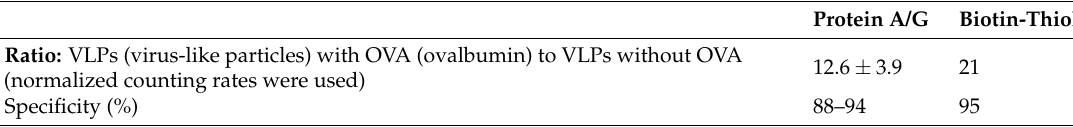
Table 1. Determination of detection specificity using HIV-VLPs (human immunodeficiency virus virus-like particles).